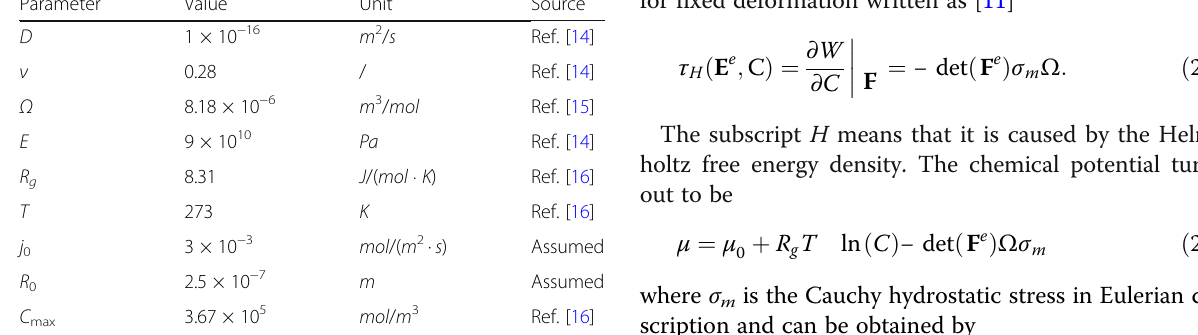
Table 1 Material properties and operating parameters